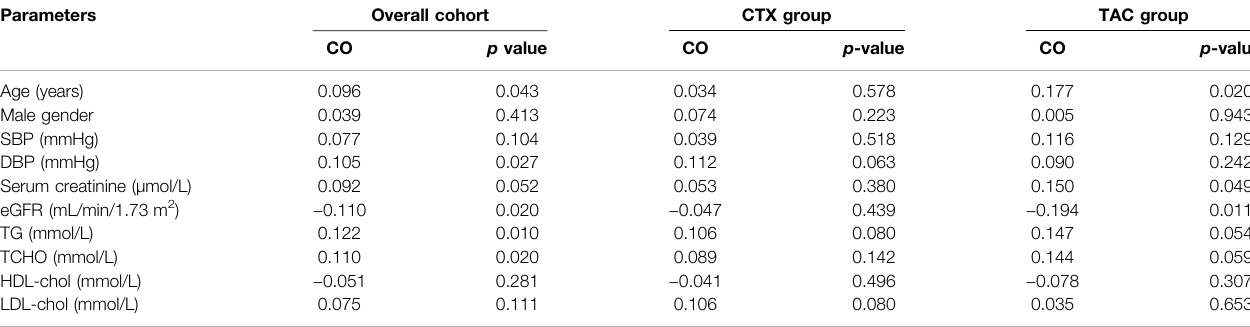
PLA2Ra, antibodies against the M-type phospholipase-A2-receptor; CTX, cyclophosphamide; TAC, tacrolimus; CO, correlation coef fi cient; SBP, systolic blood pressure; DBP: diastolic blood pressure; eGFR, estimated glomerular fi ltration rate; TG, triglyceride; TCHO, total cholesterol; HDL-chol, high-density lipoprotein cholesterol; LDL-chol, low-density